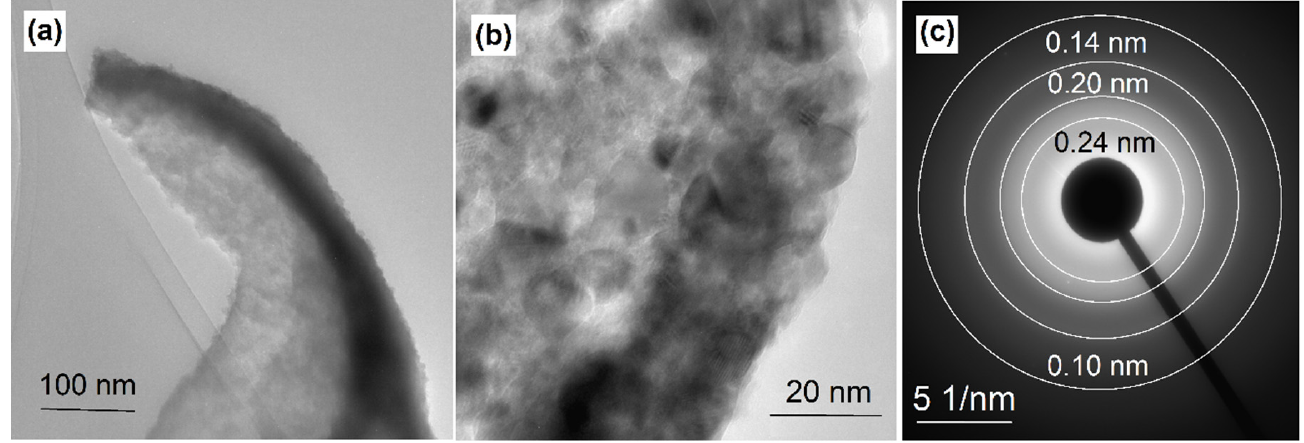
Figure 3. TEM ( a , b ) and SAED ( c ) images of nanoparticles forming the microcapsule